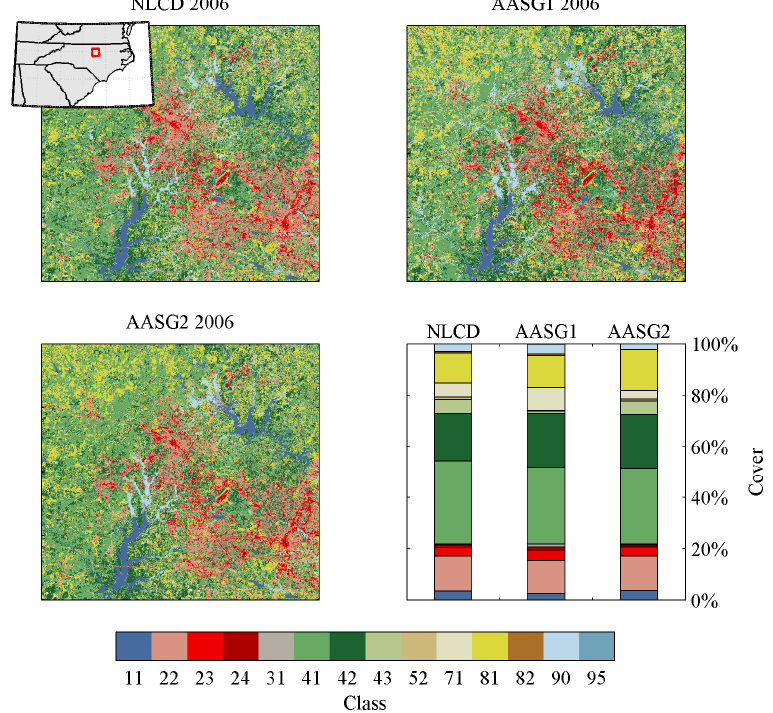
Figure 4. 2006 land cover from NLCD, AASG1, and AASG2.